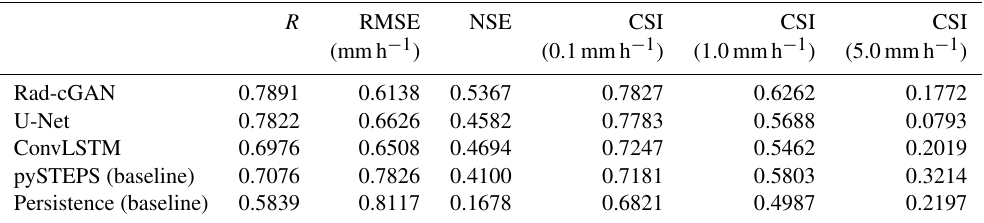
Table 4. Comparison of the average values of the verification metrics for the 10min precipitation prediction of different models at the Soyang-gang Dam basin during summer (June–August)